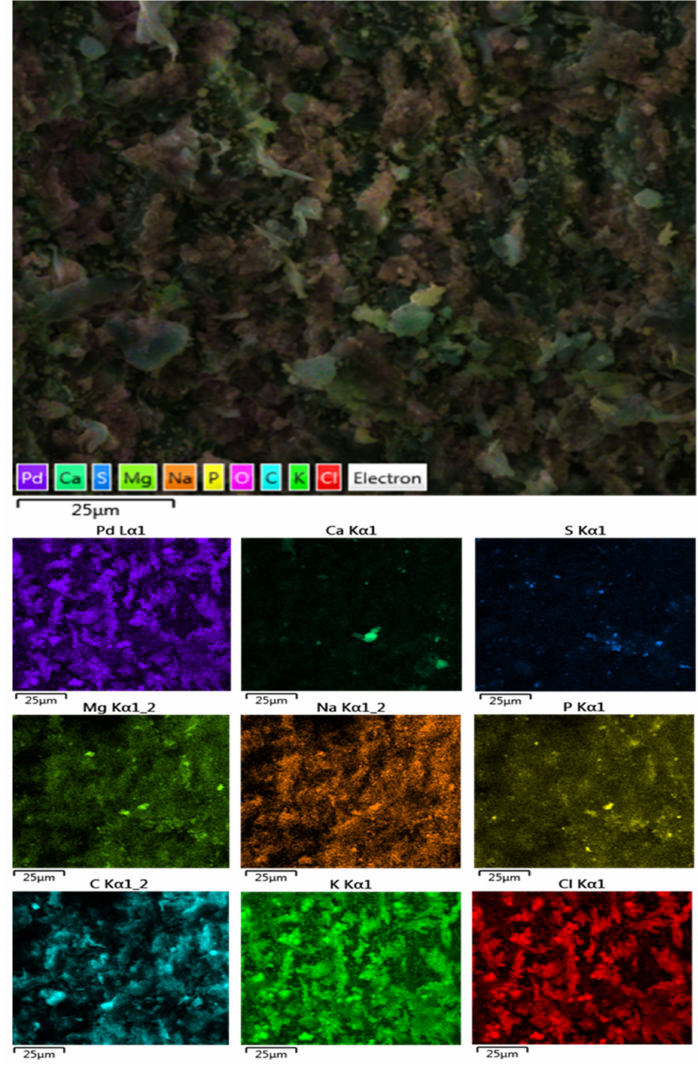
Figure 4. EDX mapping images of